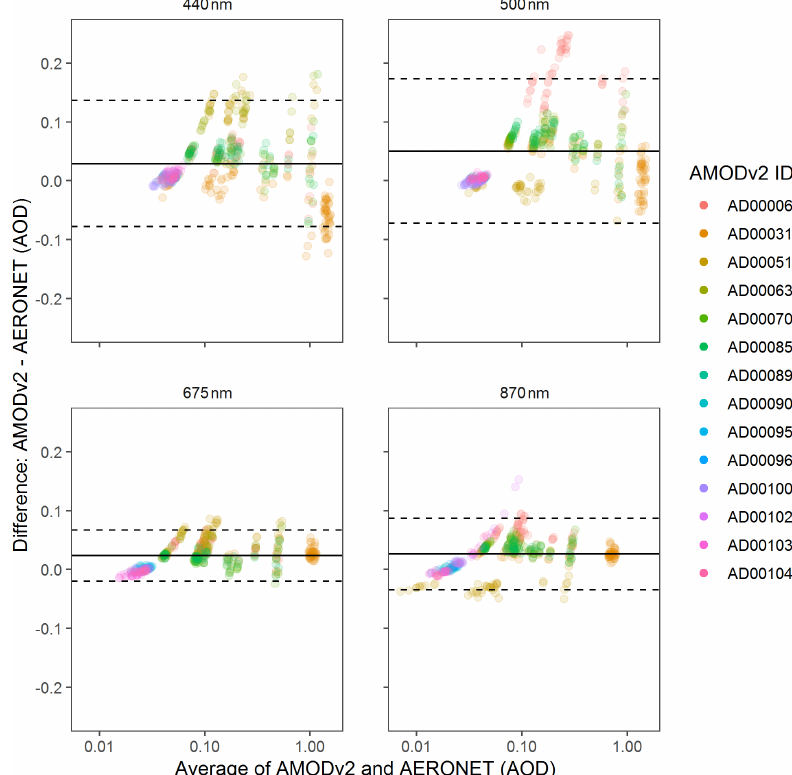
Figure 5. Mean difference plot for measurements taken by AERONET and AMODv2 instruments, with panels separated by wavelength. Paired AERONET and AMODv2 under both clear and biomass burning conditions (as defined in Table S1) are included. Points represent paired AMODv2 and AERONET measurements, with the average of the measurement pair on the x axis on a log scale and the difference on the y axis. The top and bottom dashed lines represent the upper and lower limits of agreement, respectively, evaluated at 95% confidence. The solid line between the limits of agreement is the mean difference between the two measurement techniques. Points are colored according to the AMODv2 unit